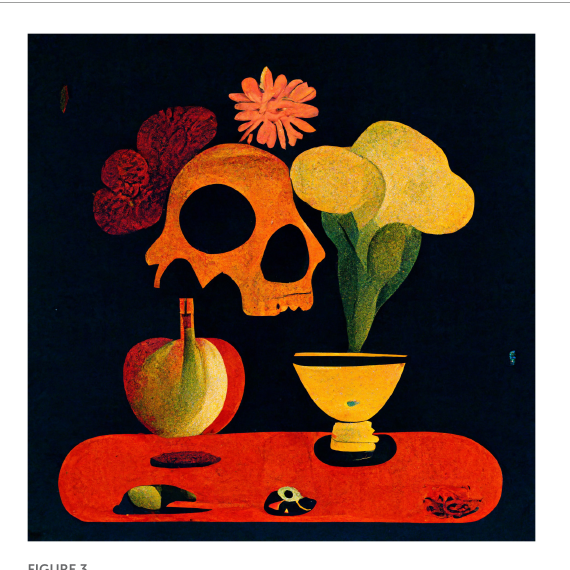
FIGURE1 Midjourney image generated to the prompt “a still life with fruit, flowers, a vase, dead game, a candle, and a skull in a Renaissance style”.